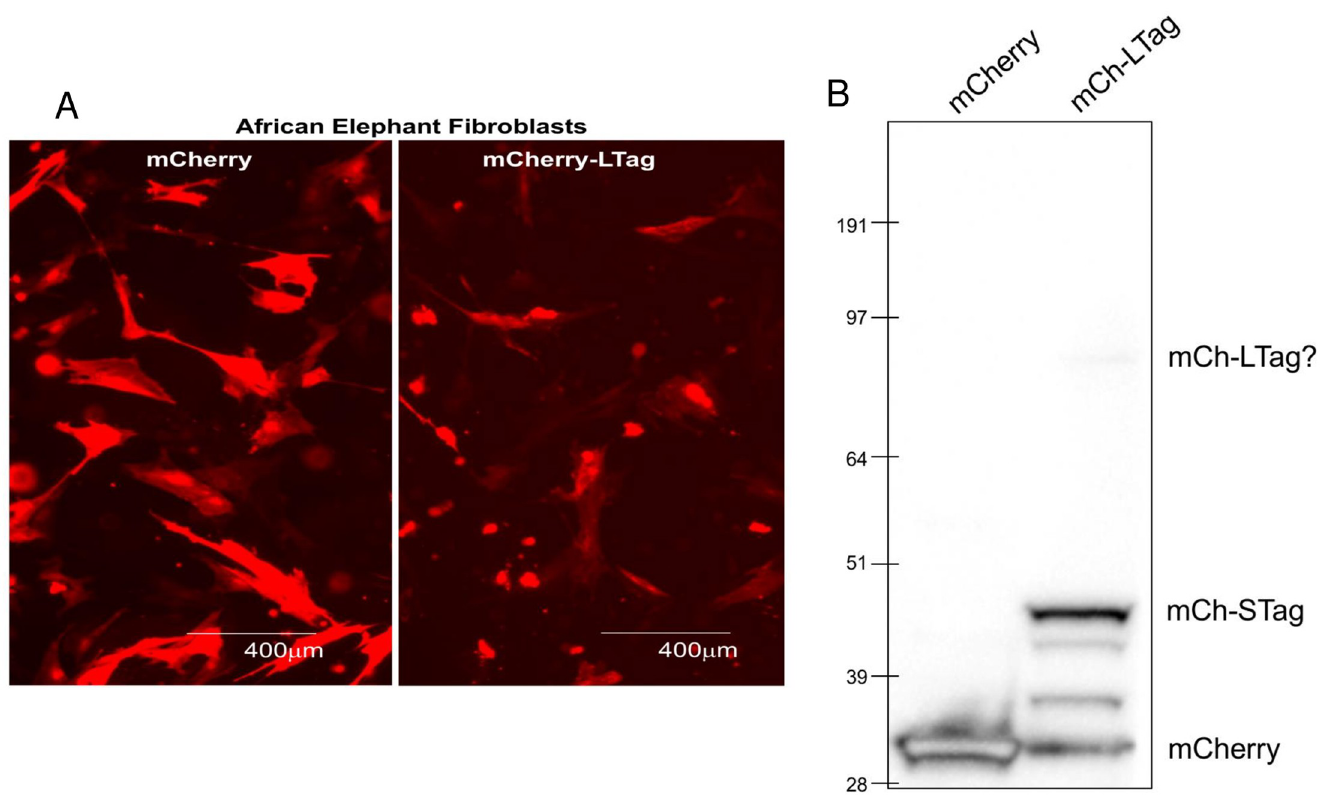
Fig 7. AelPyV1-LTag antigen expression in African elephant fibroblasts. A . African elephant fibroblasts were transfected with pAelPyV-1Tag (pcDNA3.1) +mCherry or PAelPyV-1-Tag (pcDNA3.1)+mCherry-LTag (encoding the entire early region of AeIPyV-1). 18 hours post-transfection, mCherry expression was assessed by immunofluorescence. B . 24 hours post-transfection, cells were harvested and lysed. Western blots were performed using antibody to mCherry. Predicted molecular weights: mCherry alone: 28.8 kDa; mCherry-STag: 48 kDa; mCherry-LTag: 104.6 kDa. The fluorescent fusion construct mCherry-LTA of original pAelPyV- 1-Tag appeared to interfere with protein expression of the spliced LTag region, but not with expression of STag.